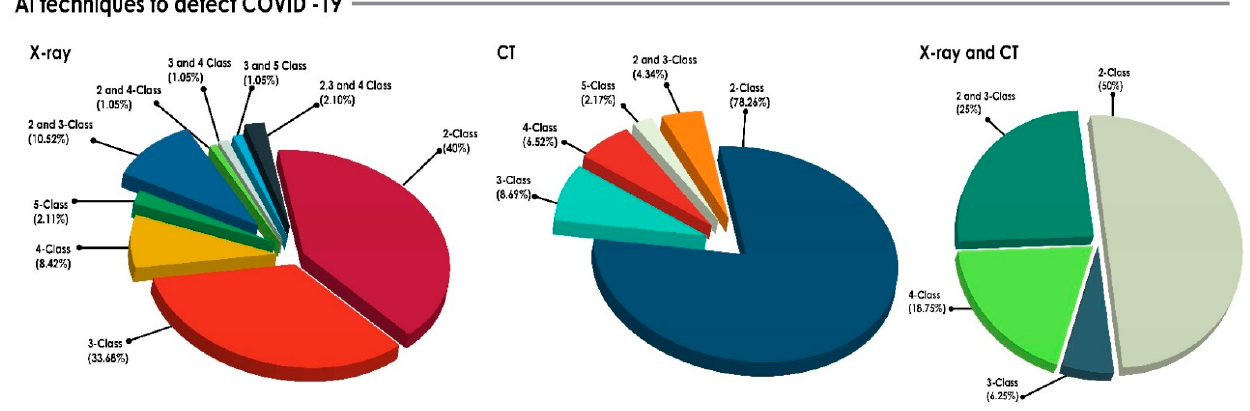
Figure 5. Percentage of various classes in the assessment of COVID-19 by imaging modalities (X-ray, CT, and X-ray and CT). Figure 5 reveals that two-class classification (Healthy vs. COVID-19 or COVID-19